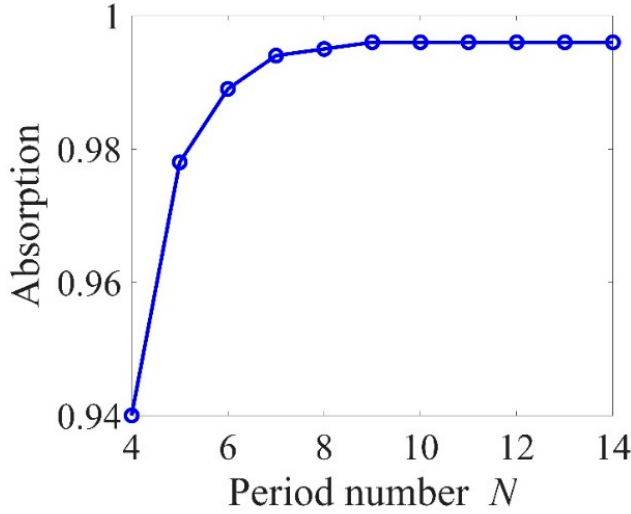
Figure 6. Peak values of light absorption of the structure with period number N when a = 0.3 μ m, h 1 = 0.53 μ m and h 2 = 0.81 μ m.